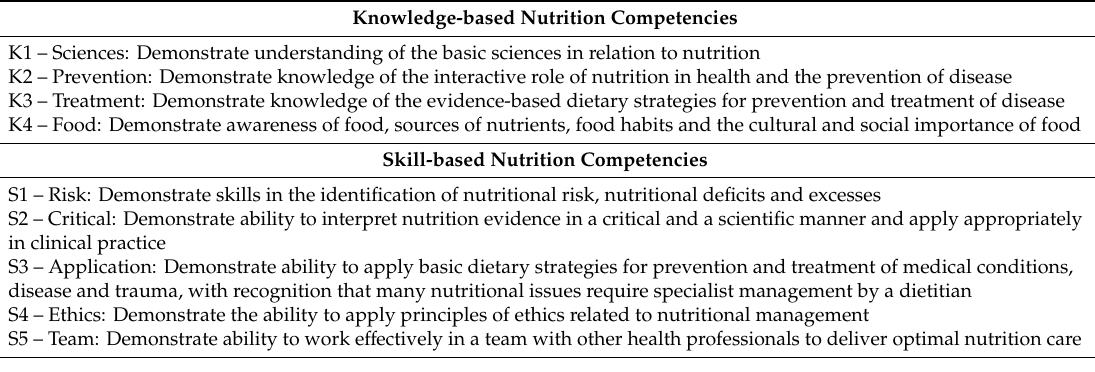
Table 1. Knowledge and skill-based nutrition competencies in The Nutrition Competency